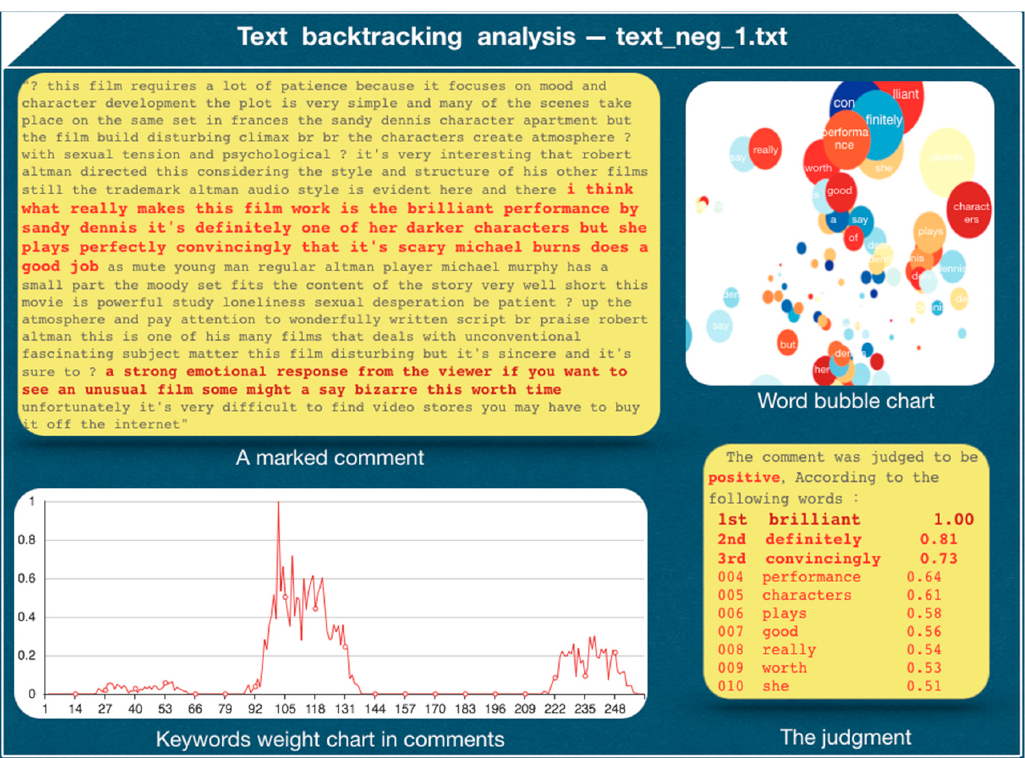
Figure 12. Comprehensive analysis diagram of IMDB dataset.